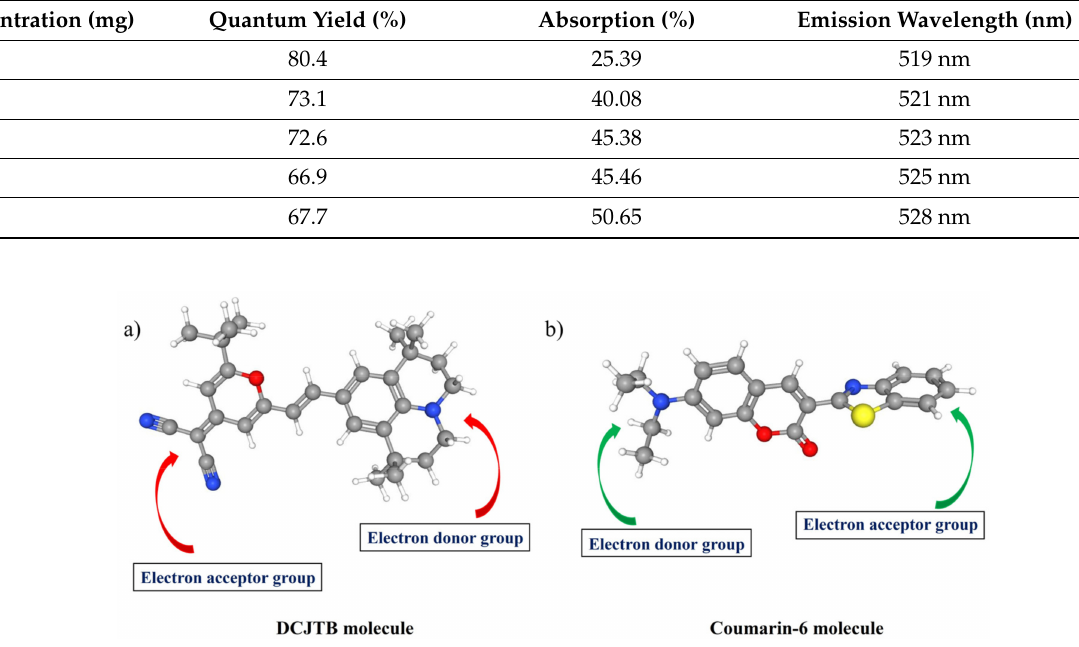
Figure 4. ( a ) The chemical structure of DCJTB and ( b ) the chemical structure of coumarin-6, with blue, red and yellow balls representing N, O and S atoms,